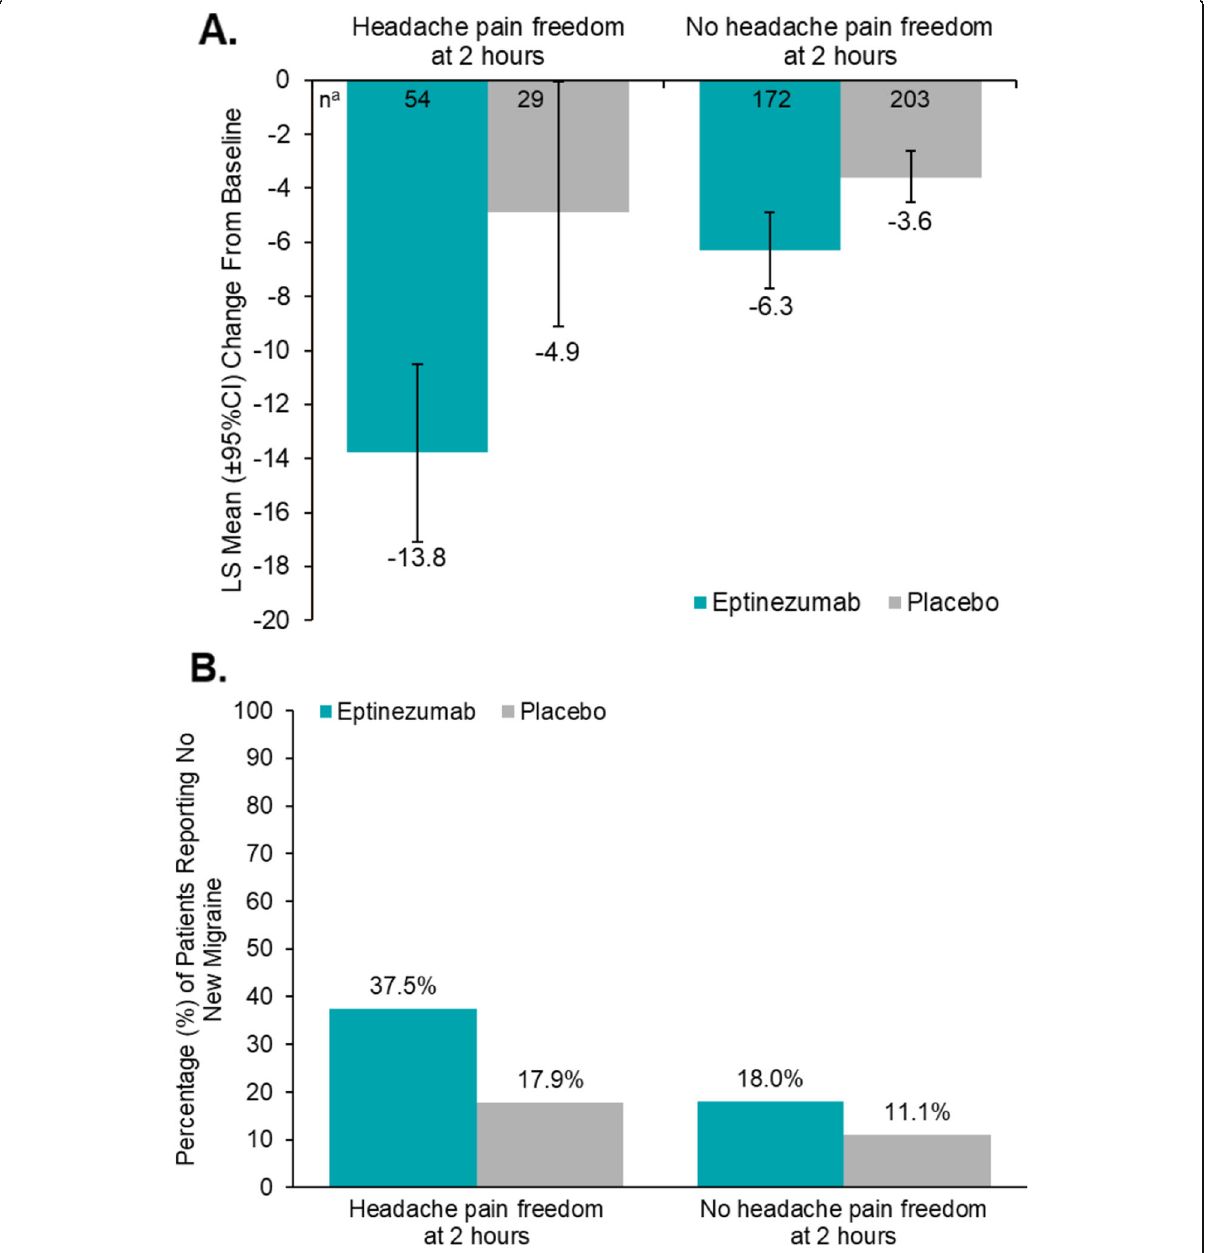
Fig. 2 Relationship of 2-h Pain Freedom to Change in HIT-6 and Occurrence of Subsequent Migraine. A Mean Change From Baseline to Week 4 in HIT-6 Total Score and B Percent of Patients Without a New Migraine Occurring With or Without Headache Pain Freedom at 2 Hours After Infusion Start. CI, confidence interval; HIT-6, 6-item Headache Impact Test; LS, least square. a Limited to patients with both baseline and post- baseline HIT-6 data Error bars represent 95%